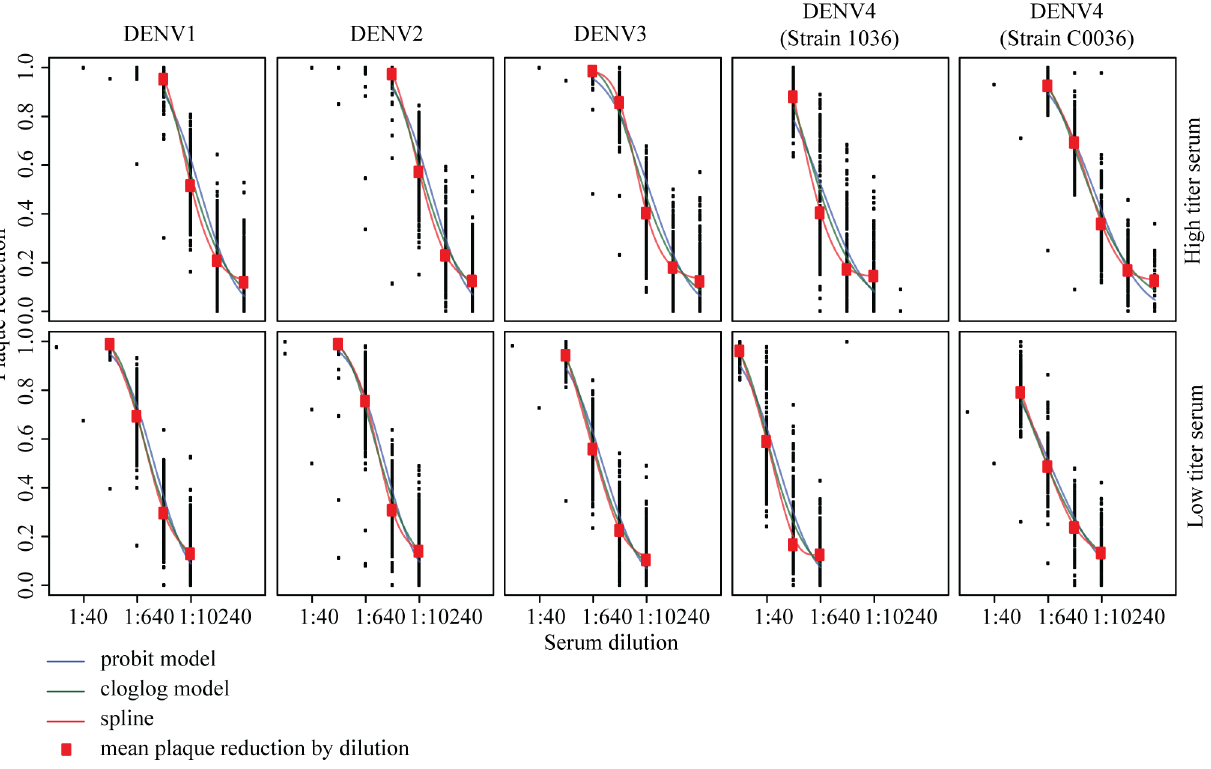
Figure 1. Plaque reduction estimates for each experiment. Each black dot represents the mean reduction in plaques formed for that dilution from two repeats. The red dots are the overall means across all the experiments. Superimposed are fitted models using a probit transformation, a cloglog transformation and a non-parametric spline (the estimate of the ‘true’ titers).